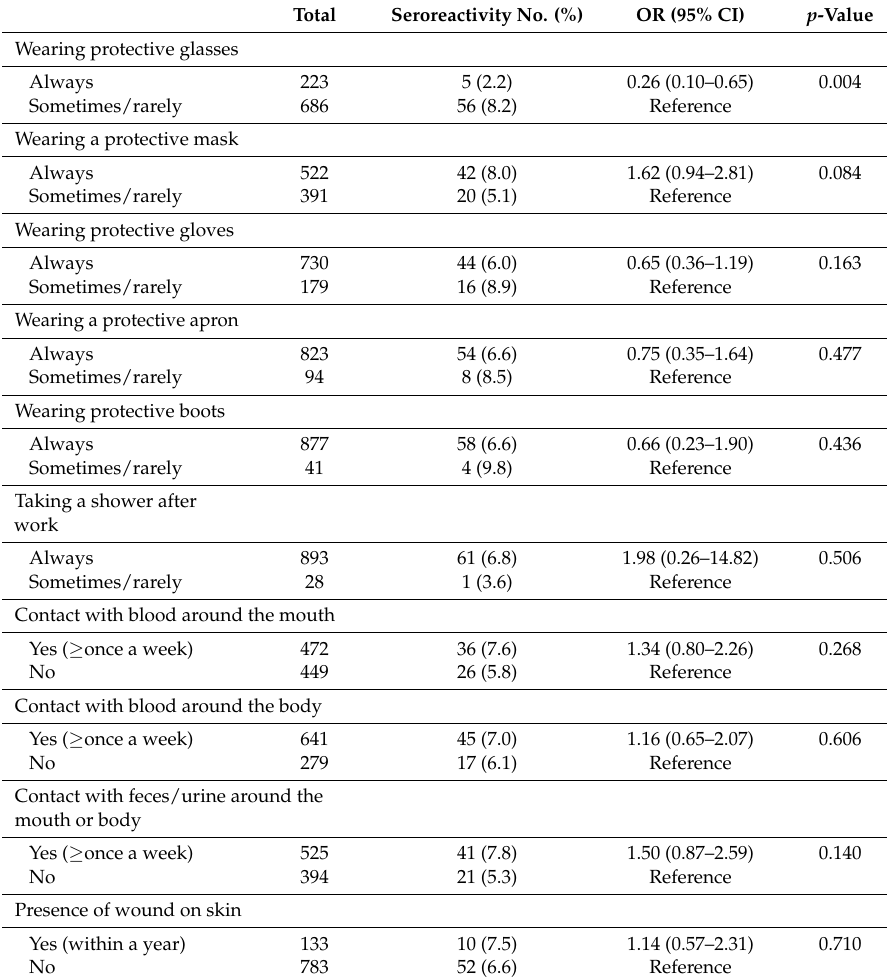
Table 3. Univariate logistic regression analysis of the association between work hygiene-related factors and brucellosis seroreactivity among cattle slaughterhouse workers in South